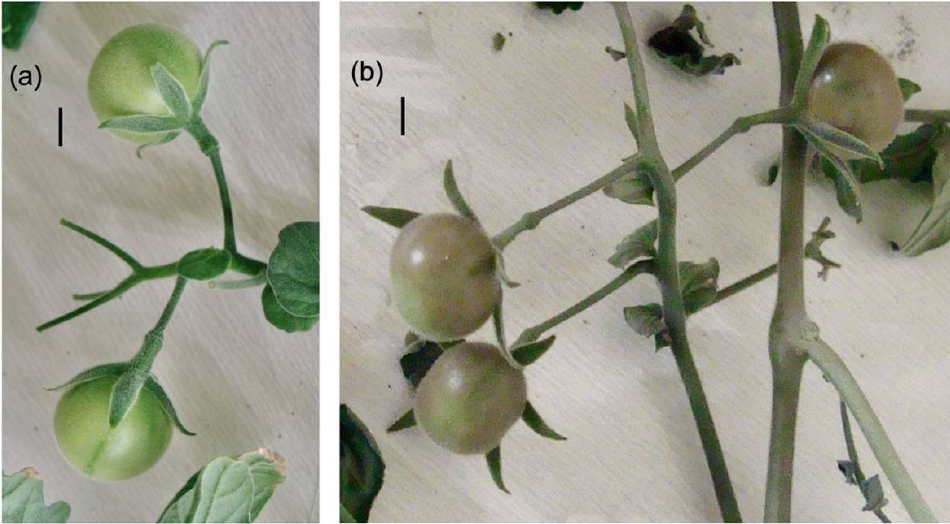
Figure 5. Fruit attached to Solanum peruvianum accession QUI958 plants of the UV-B experiment. UV-B-treated fruit at 0 and 24 h are shown in panels ( a , b ), respectively. The bar in each panel represents 1 cm. For details see the Section 2.